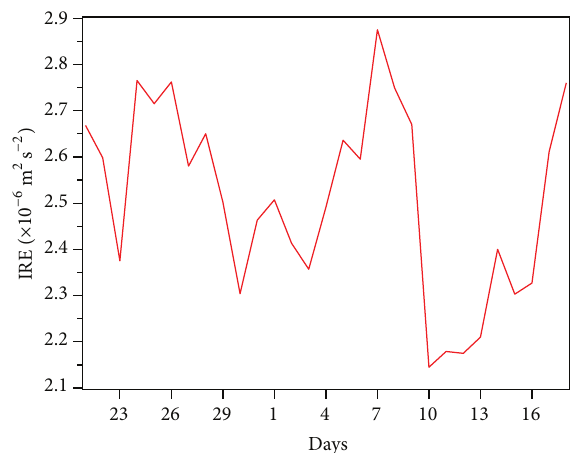
the change in flow regimes, including the onset and decay periods for blocking events. The past research has shown that block onset and decay are associated with relative maxima in phase of a blocking event, the enstrophy dips to a relative Figure 11. The IRE reaches a relative maximum near onset and rises to another relative maximum at block decay, indicating